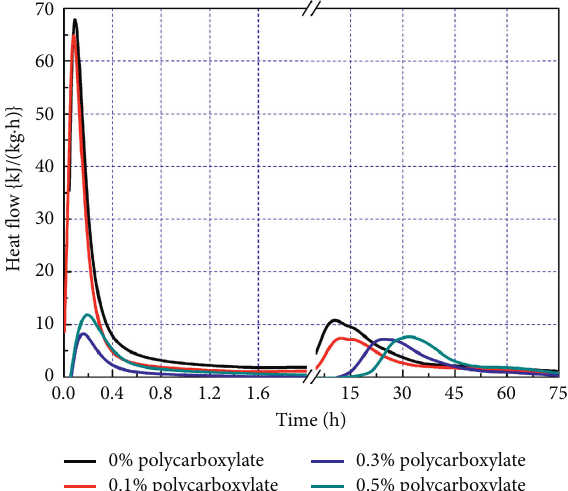
Figure 5: Effect of PCE-2 dosage on hydration heat flow of cement pastes with 10% slag.